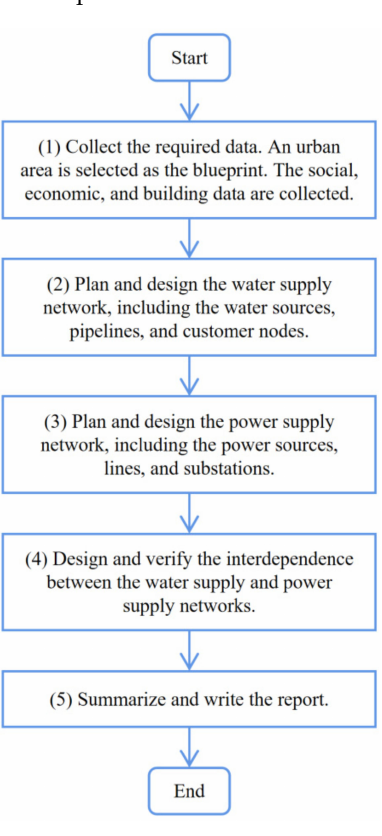
Figure 1. Framework for designing virtual water and power supply networks with interdepend- ent